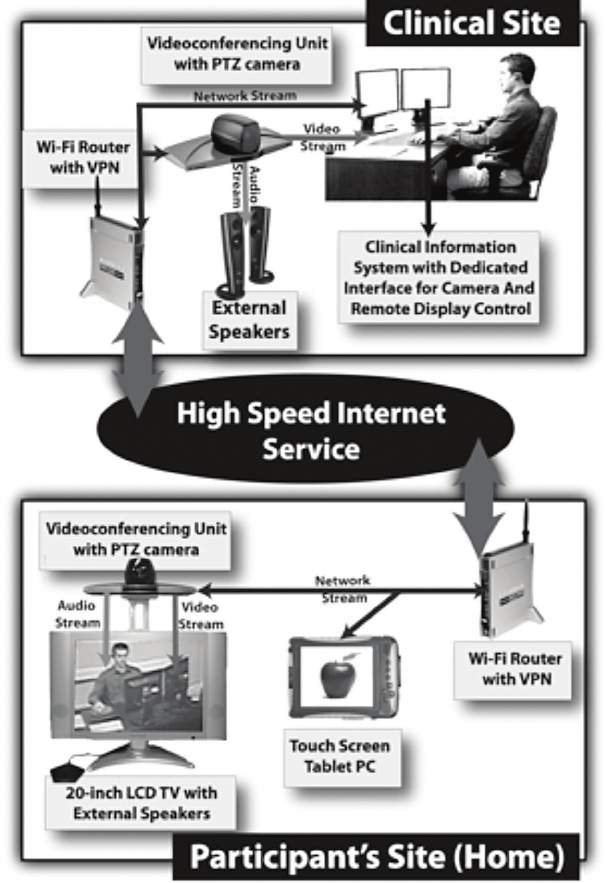
Figure 1: Technological infrastructure for speech therapy teletreatment services.